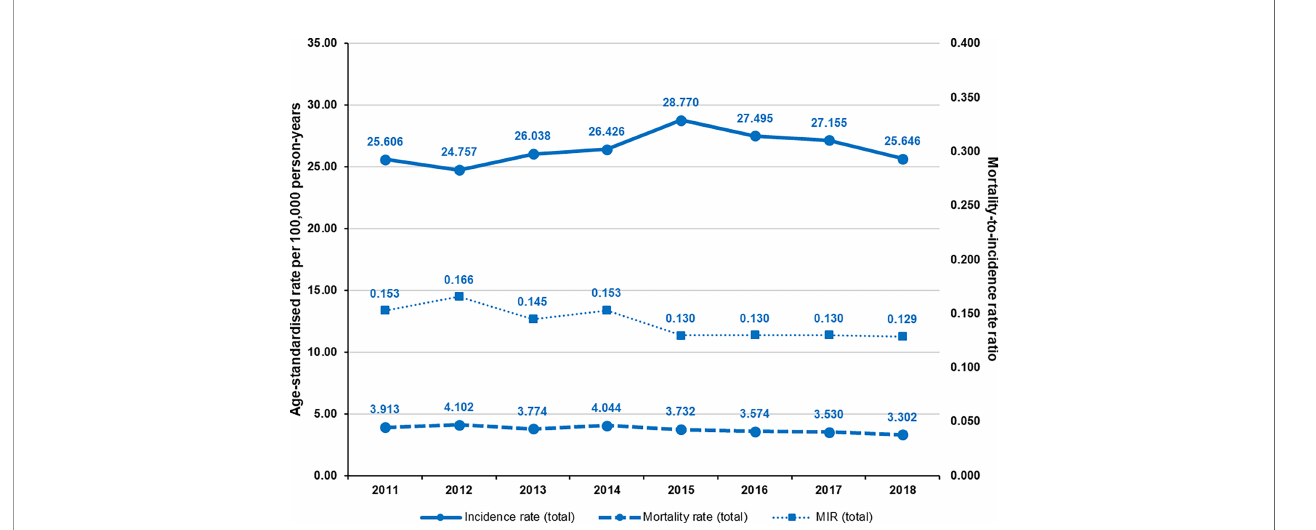
FIGURE 1 | Age-standardized incidence rates, mortality rates, and mortality-to-incidence ratios of melanoma in Hungary between 2011 and 2018 (per 100,000 person-years, using ESP